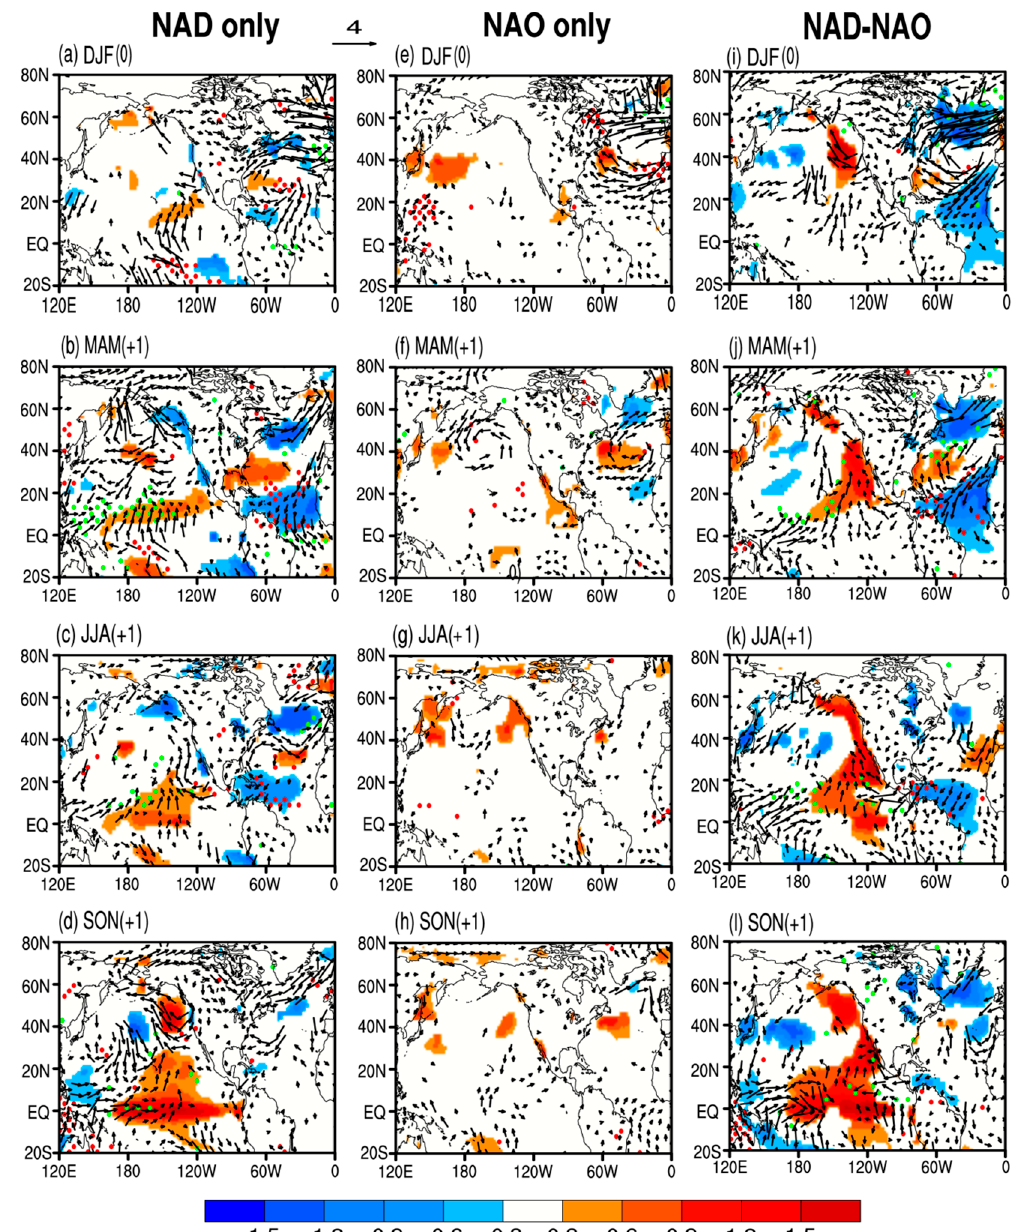
Figure 7. Composite differences of three-month-averaged SST (°C; shaded), surface wind (m s –1 ; vectors) and precipitation (mm day –1 ; stippled) anomalies between the positive and negative NAD only (a–d), between the NAO only (e–h), and between NAD–NAO (i–l), for DJF(0), MAM(+1), JJA(+1), and SON(+1). Only SST, surface wind, and precipitation anomalies are significant at the 90% confidence level are shown.